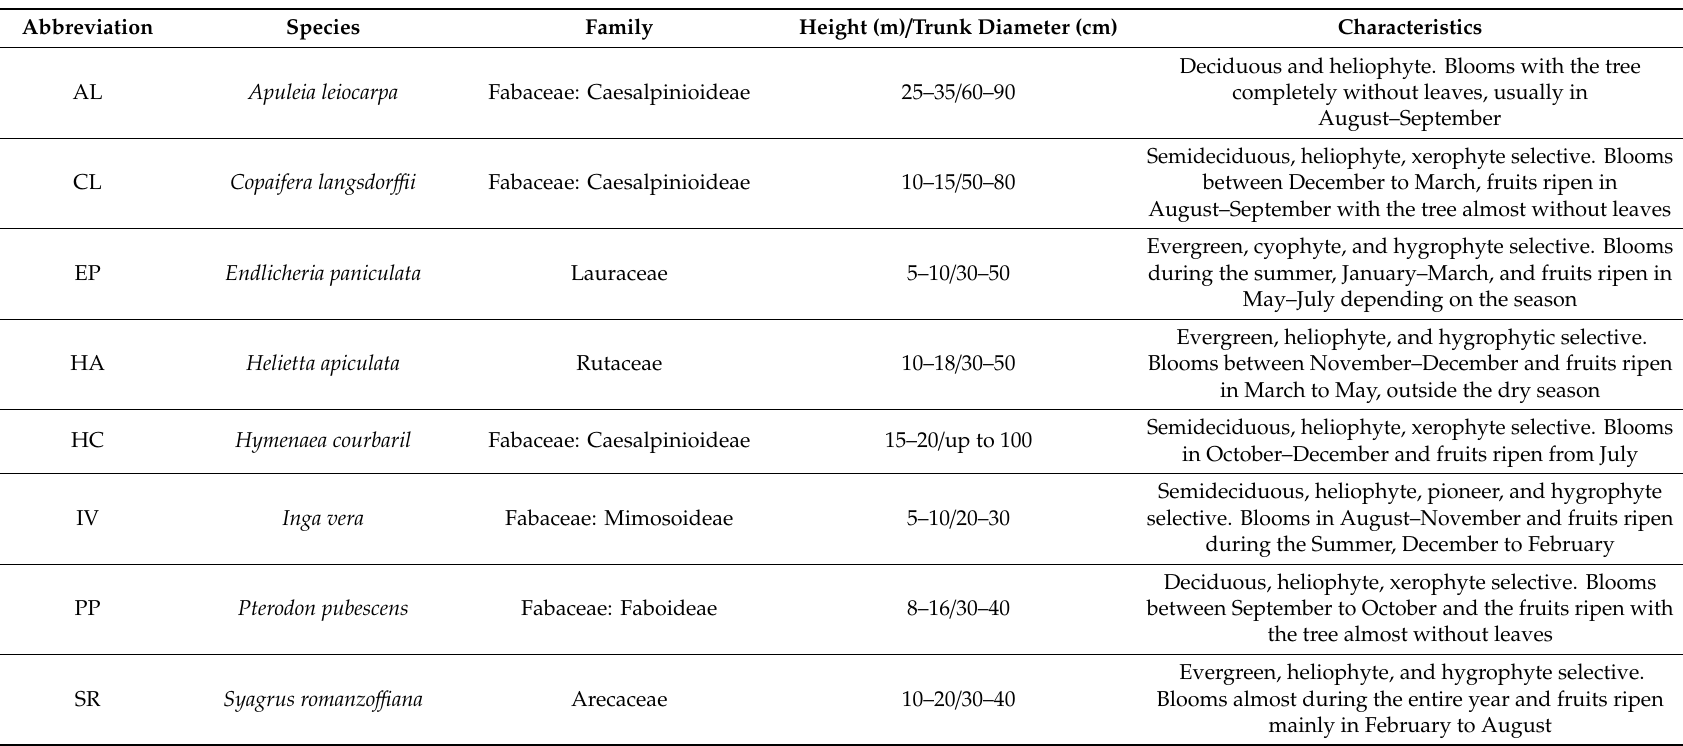
Table 2. Tree species identified in the field and their characteristics 1